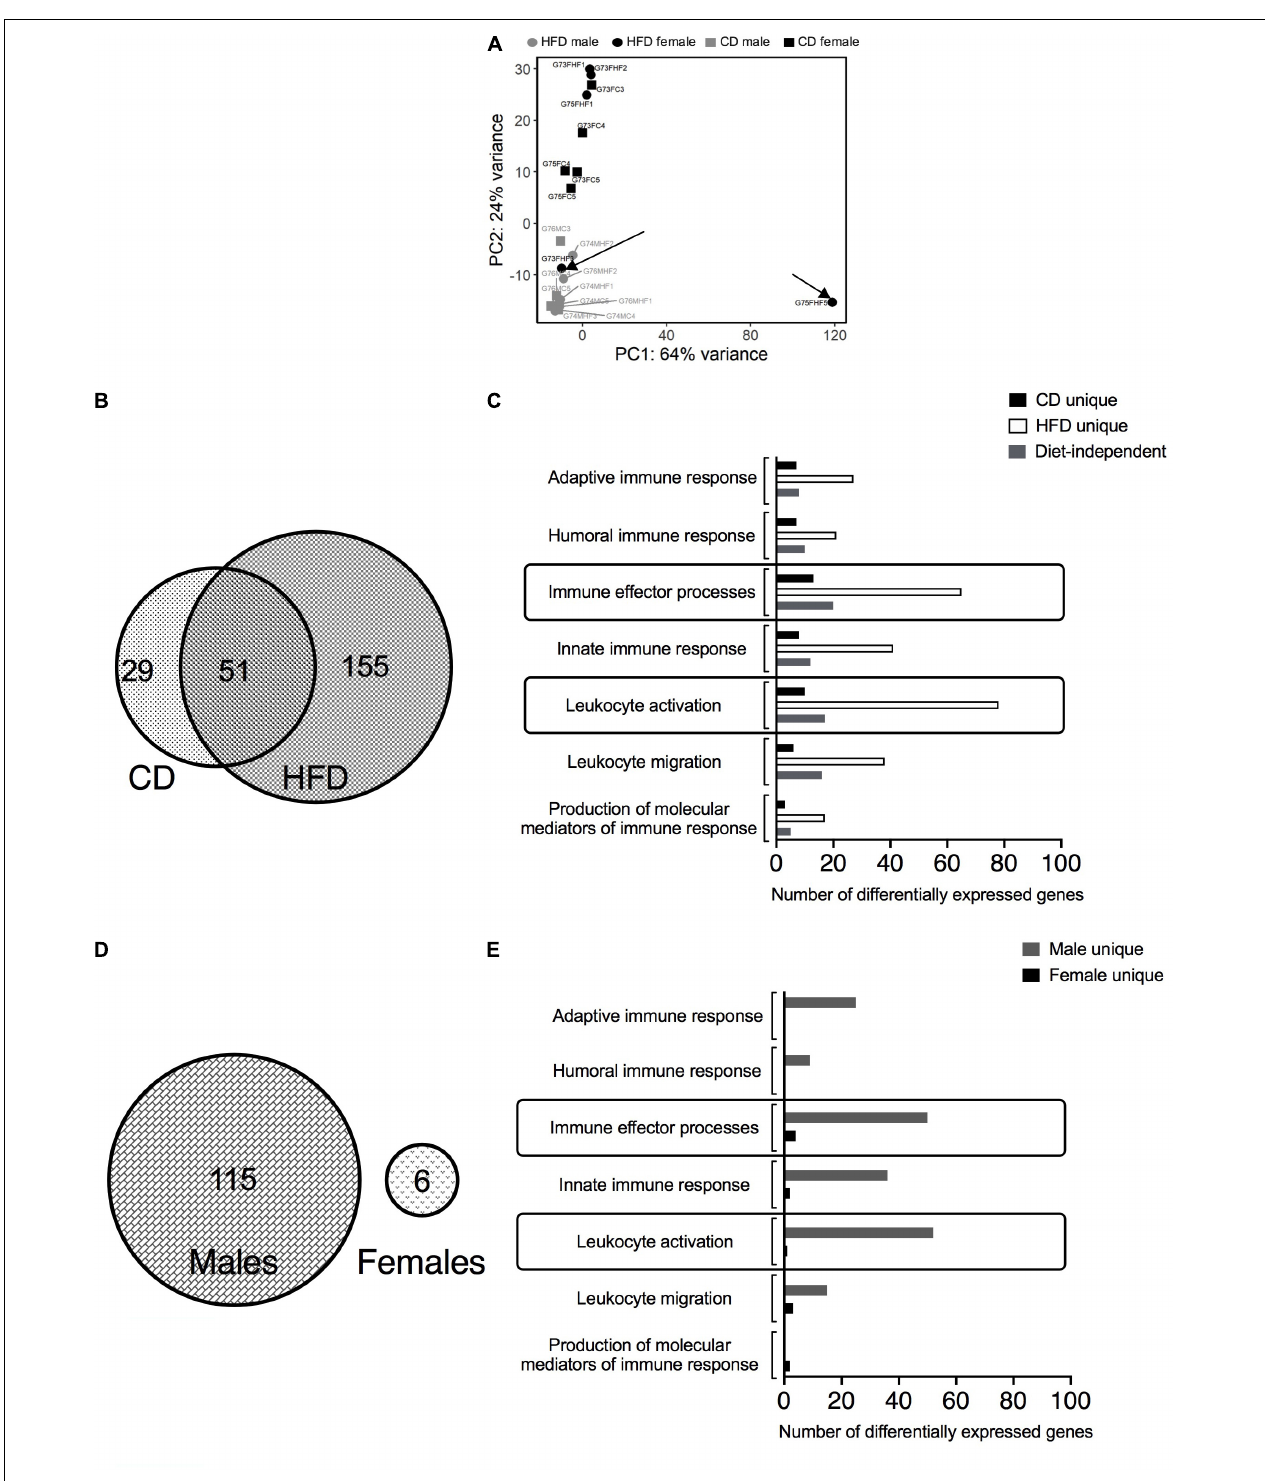
FIGURE 1 | Bulk RNA-sequencing in MRPVAT of both sexes after 24 weeks on diet. Bulk RNA sequencing was performed on MRPVAT at 24 weeks on diet, from both sexes. Principal Component Analysis contained all the 20 samples (5 sample/diet/sex). (A) Venn diagram with the number of immune-related differentially expressed genes (DEGs) with respect to sex differences with HFD vs. CD (B) and the specific immune system processes affected (C) . Venn diagram with the number of immune-related DEGs with respect to diet differences in males vs. females (D) and the specific immune system processes affected (E) . G#: group number; M: male, F: female; C: CD; HF: